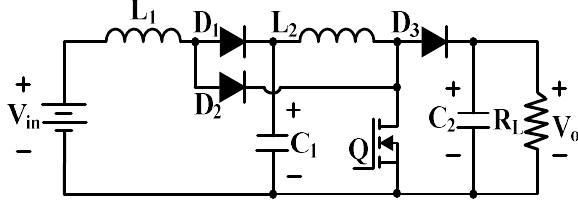
Figure 16. Cascade boost converter.